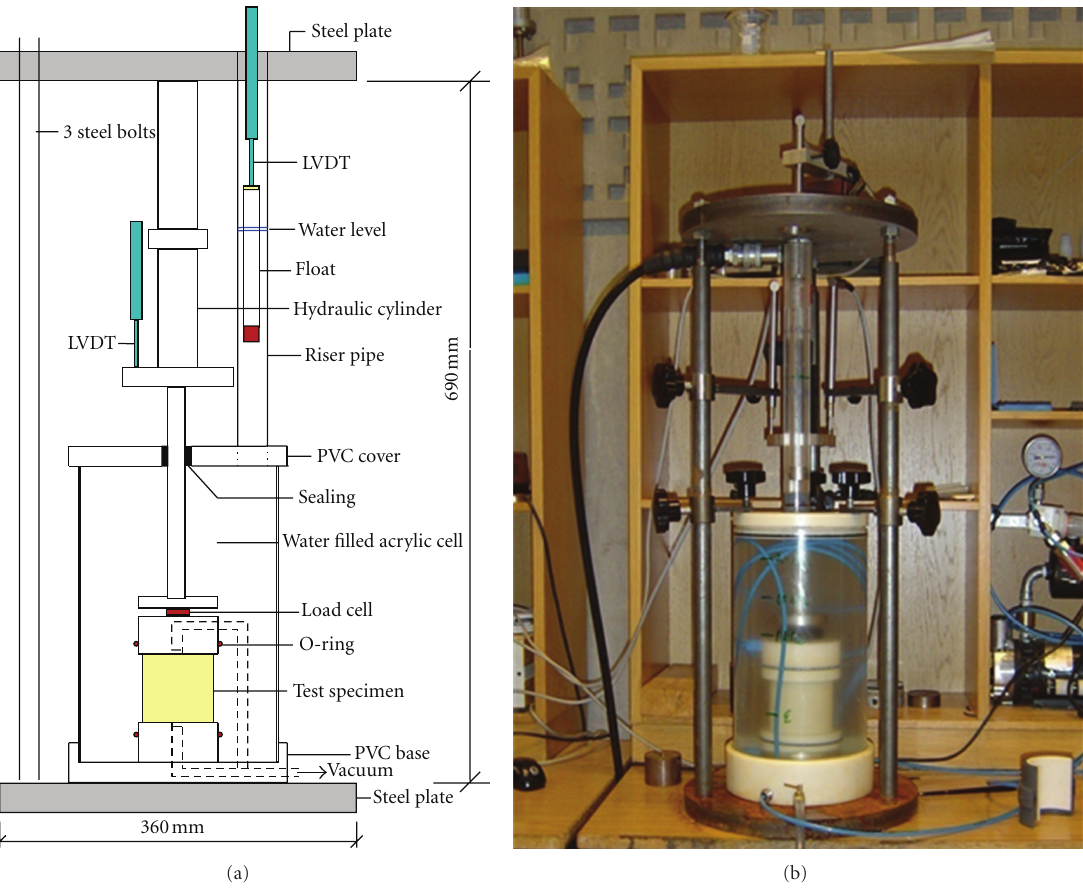
Figure 1: Schematic drawing and photograph of the triaxial test